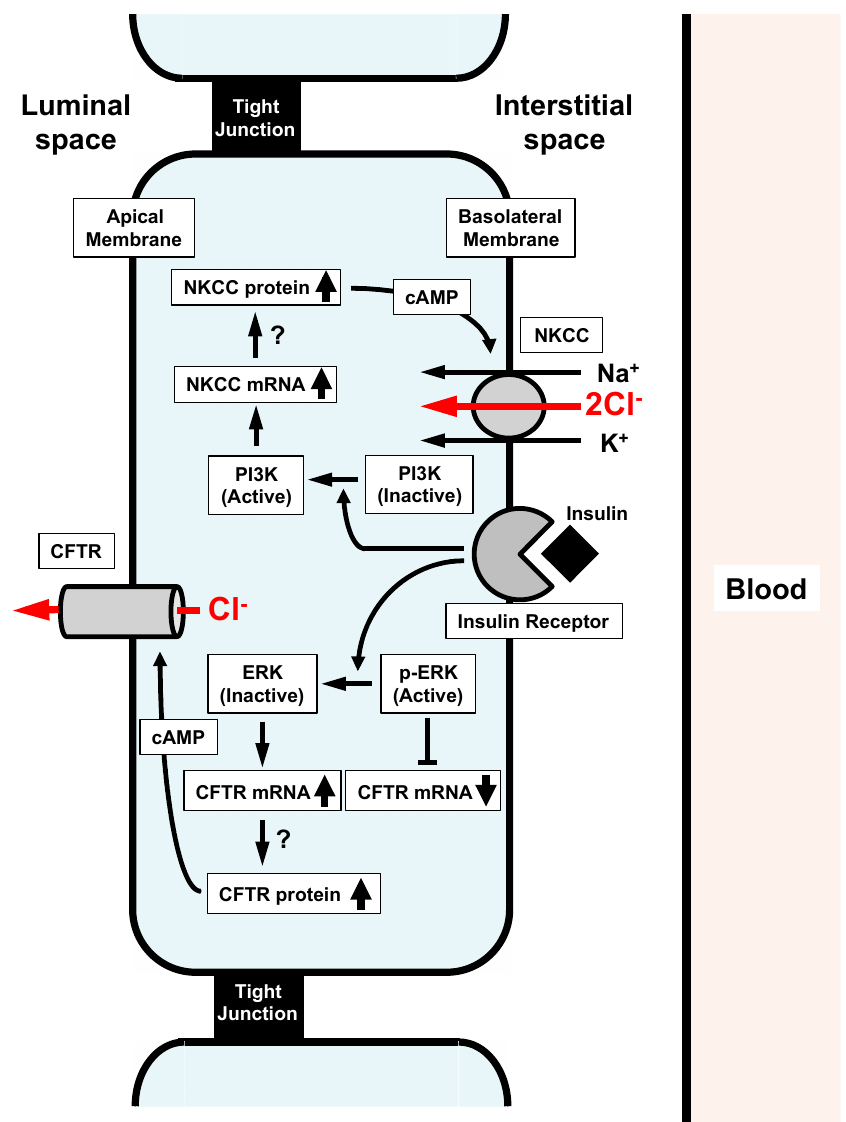
Figure 3. Insulin action on Na + -K + -2Cl − cotransporter (NKCC) and cystic fibrosis transmembrane regualtor (CFTR) participating in Cl − secretion of epithelial cells. (1) Insulin activates PI3K, resulting in stimulation of NKCC mRNA expression. (2) Insulin inactivates ERK, which suppresses CFTR mRNA expression. Insulin-induced inactivation of ERK releases the suppression of CFTR mRNA expression, leading to the elevation of CFTR mRNA expression. Both the elevation of mRNA expression of NKCC and CFTR induced by insulin might stimulate expression of NKCC and CFTR proteins, which might stay in cytosolic store sites. cAMP respectively stimulates the translocation of insulin-induced NKCC and CFTR proteins staying in cytosolic store sites to the basolateral and apical membranes, leading to a much larger epithelial Cl − secretion associated with a much larger elevation of CFTR activity